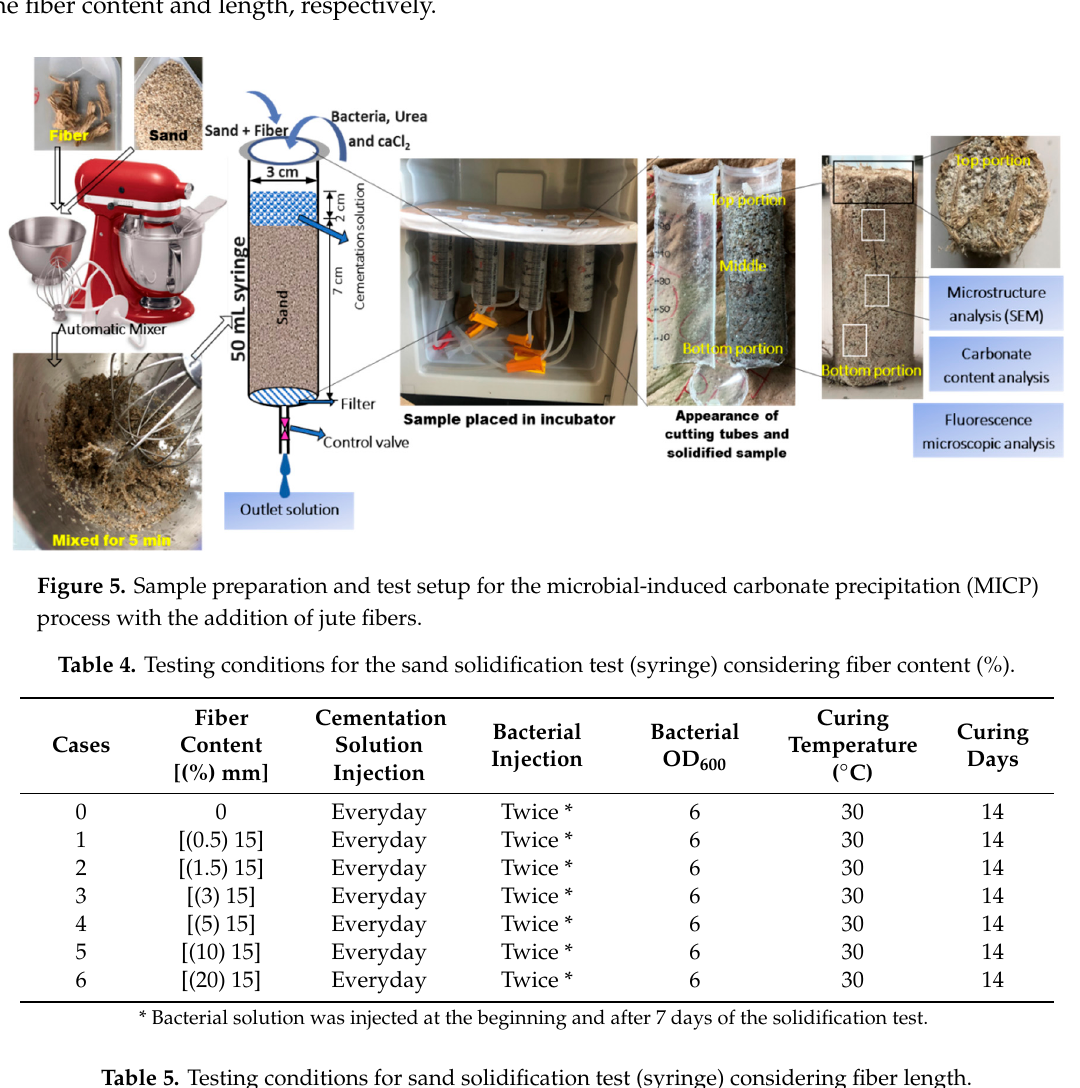
Table 5. Testing conditions for sand solidification test (syringe) considering fiber